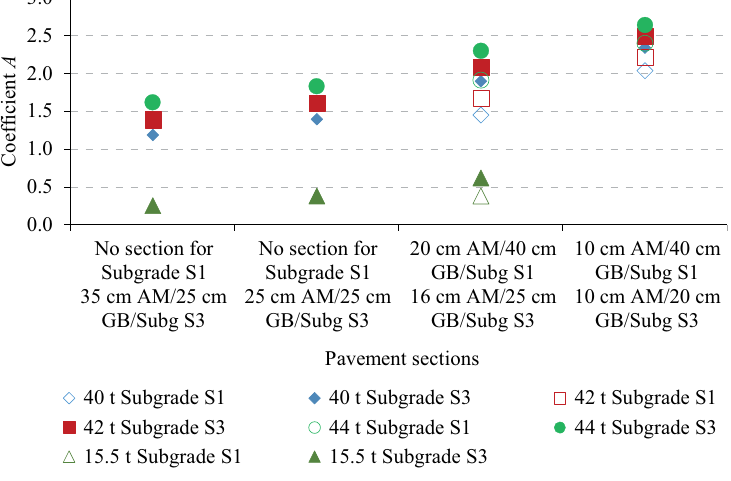
Figure 5. Aggressiveness coefficient for a heavy vehicle on flexible